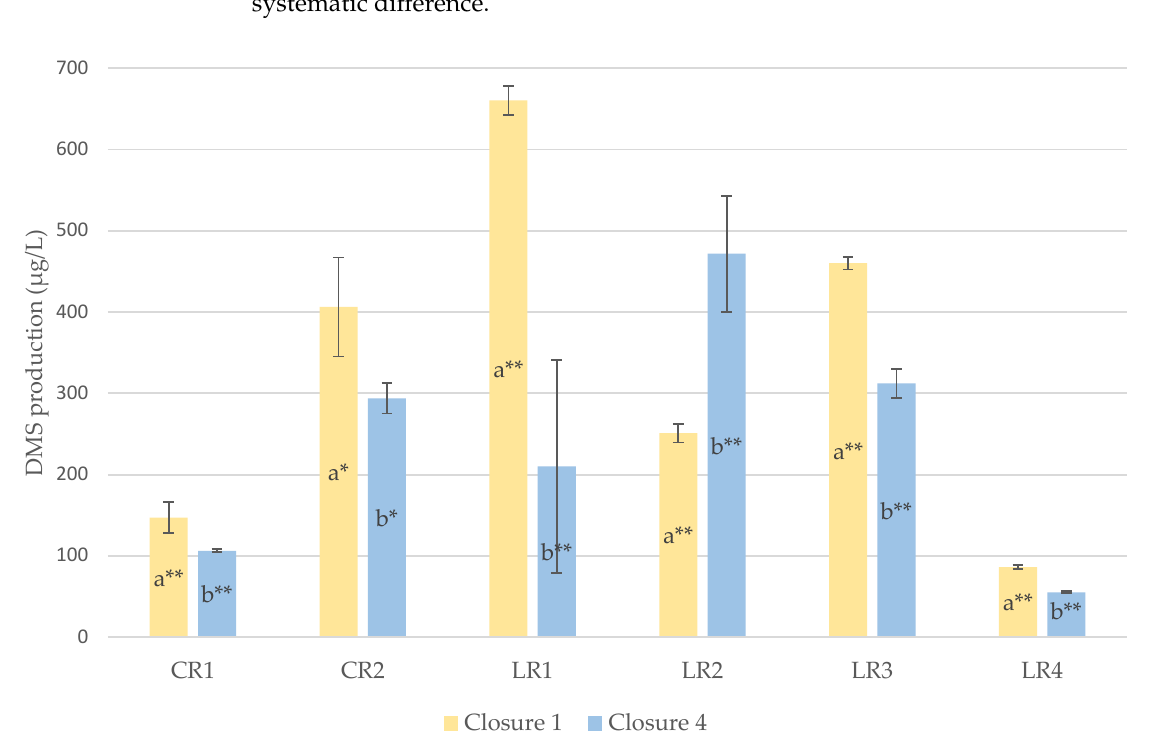
Figure 1. Evolution of the DMS concentration ( μ g/L) between bottling (t0) and after three months of accelerated bottle ageing (t3) for six different wine samples (CR1, CR2, LR1, LR2, LR3 and LR4) (a and b: a different letter means there is a significant difference between the two groups; **: signif ‐ icant difference at 5%).